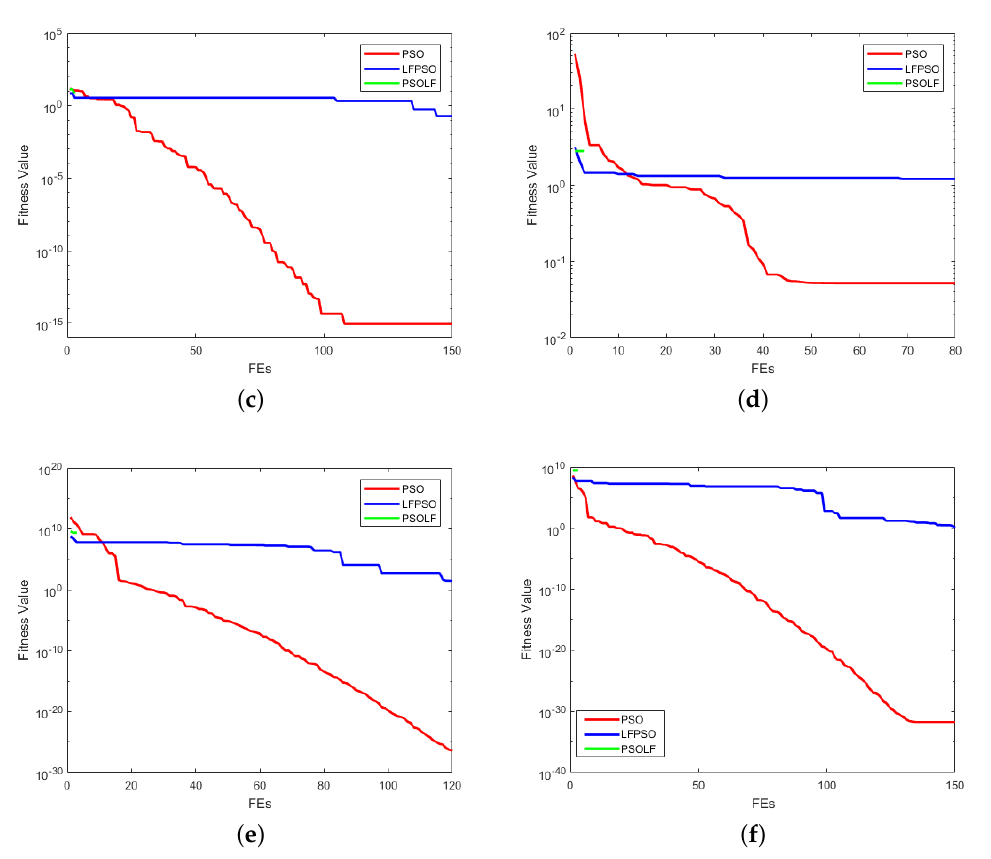
Figure 9. Multimodal Functions. ( a ) SCHWEFEL2.26; ( b ) RASTRIGIN; ( c ) ACKLEY; ( d ) GRIEWANK; ( e ) PENALIZED1; ( f )